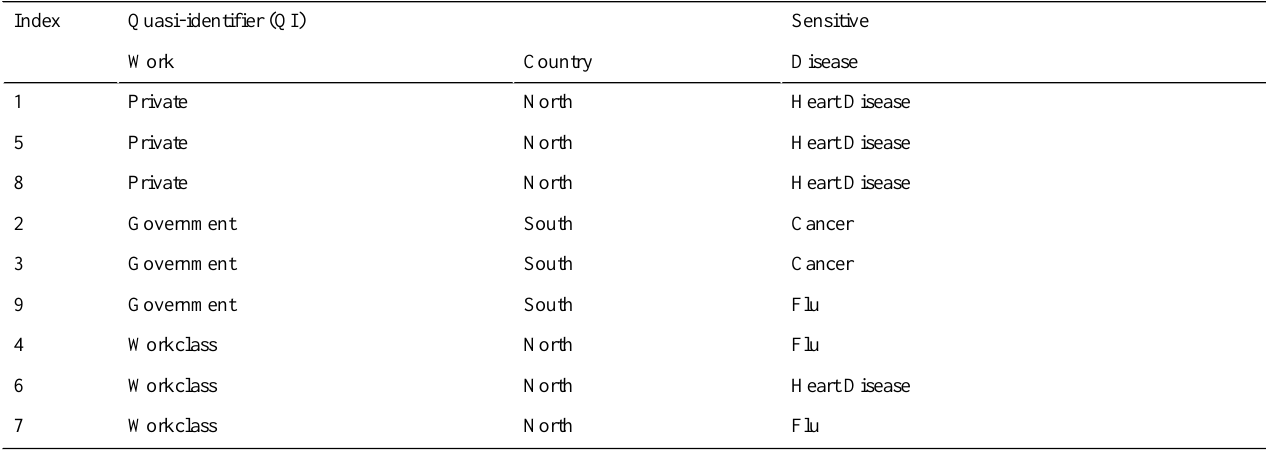
Table 2. An example of a 3-anonymous data table after generalization.